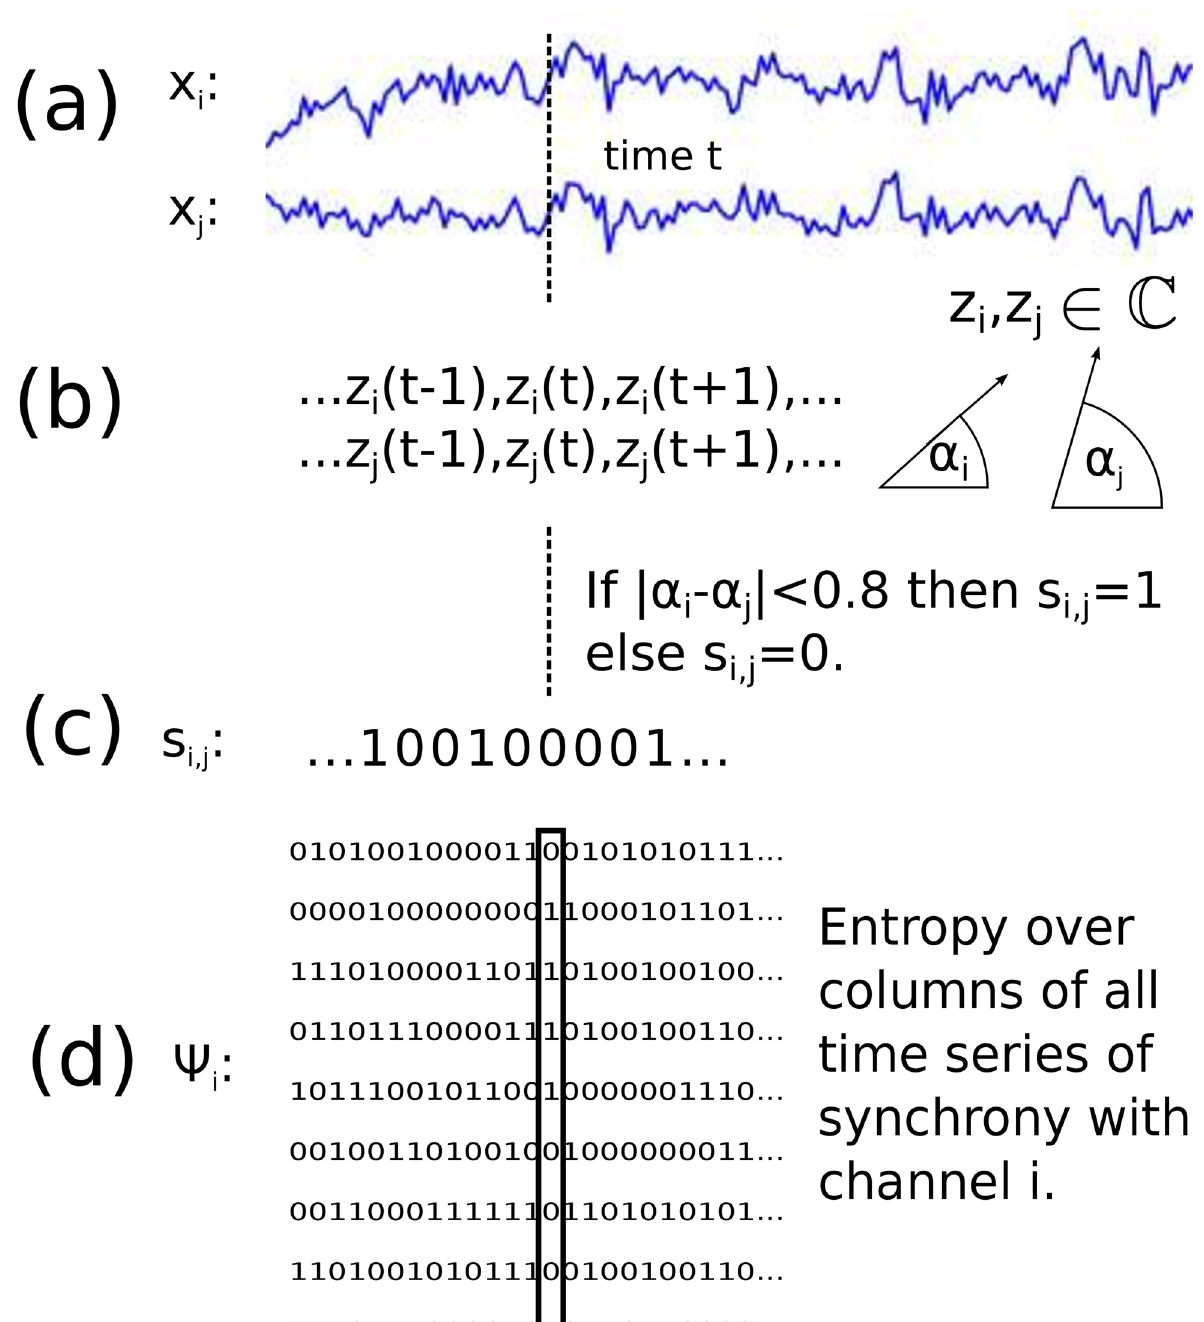
Fig 4. Schematic of the computation of SCE. a) Two time series. b) The analytic signals of these two, being complex signals with the real part being the original signal and the imaginary part being the Hilbert transform of the signal. c) A synchrony time series is created for this pair of signals, being 1 at time t if the phases of the complex values of the analytic signals have similar magnitude at this time t . d) SCE ( i ) with respect to channel i is the entropy over columns ( n × 1 synchronies) of the matrix Ψ i containing all n synchrony time series for channel i . The overall SCE is then the mean value of the SCE ( i ) across